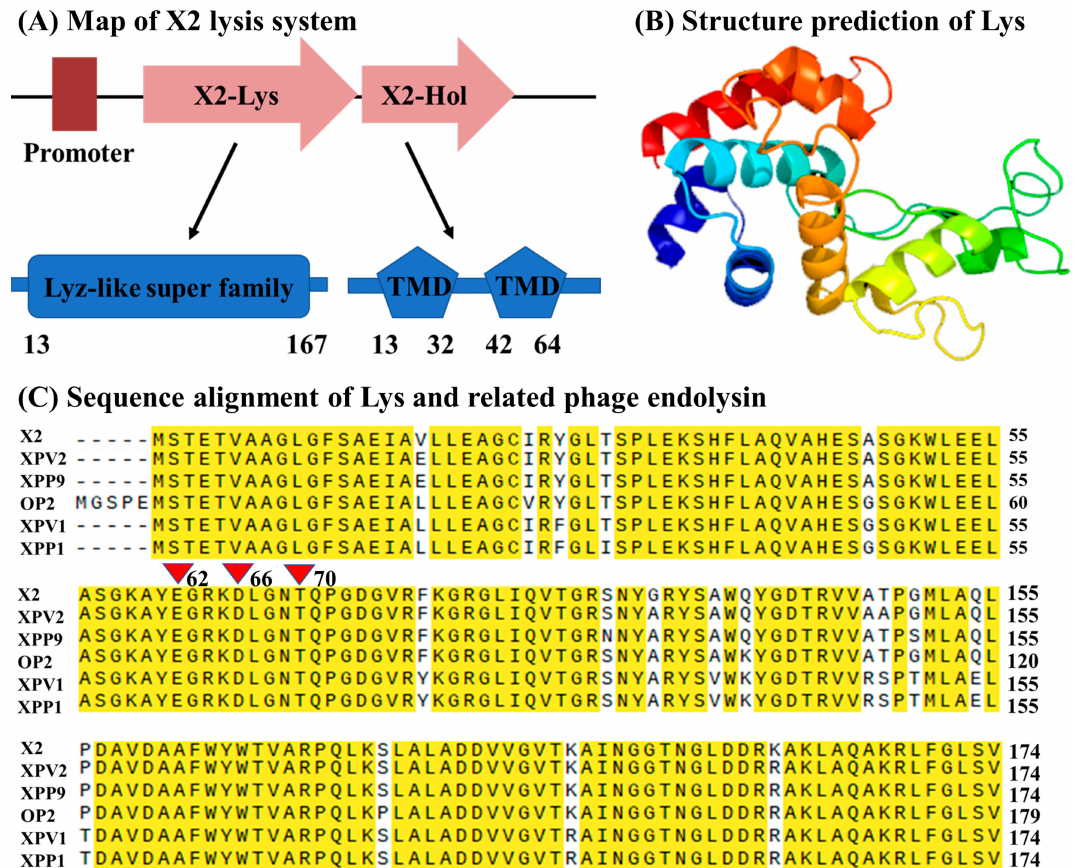
Figure 3. In silico analysis of phage X2 lysis system. ( A ) Schematic representation of the X2 lysis system. Numbers indicate the amino acid position. TMD: transmembrane domain. ( B ) Three-dimensional structure prediction of X2-Lys. The confidence is 100%, the coverage is 93%. ( C ) Sequence alignment of X2-Lys with that of phage XPV2, XPP9, OP2, XPV1 and XPP1 (Accession no. AVO24273.1, AVO24087.1, YP_453642.1, AVO24202.1 and AVO23647.1, respectively). Red triangles (62, 66 and 70) are the key residues (Glu11, Asp20 and Thr26) in the catalytic triad of phage T4 lysozyme,